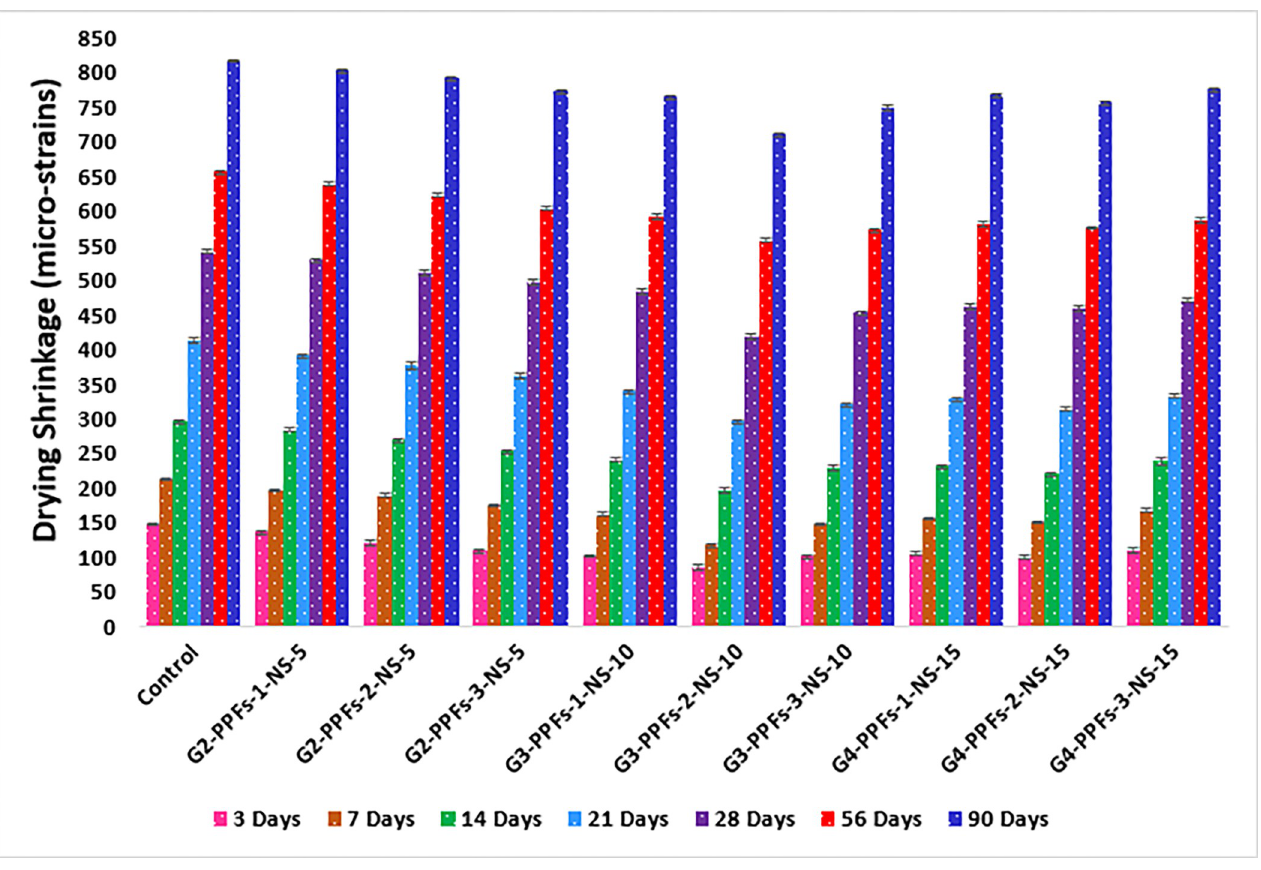
Fig 17. Drying shrinkage result of